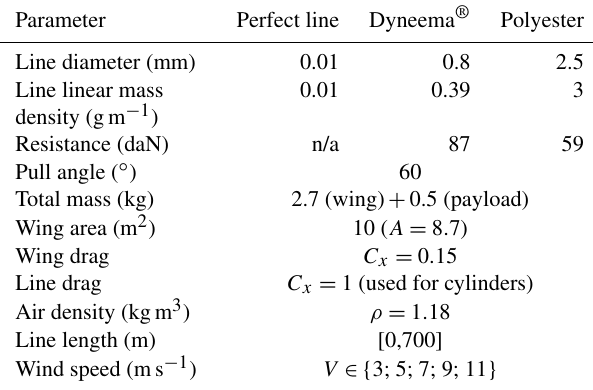
Table 1. Parameters used for the simulation of line shapes and flight angle Parameter Perfect line